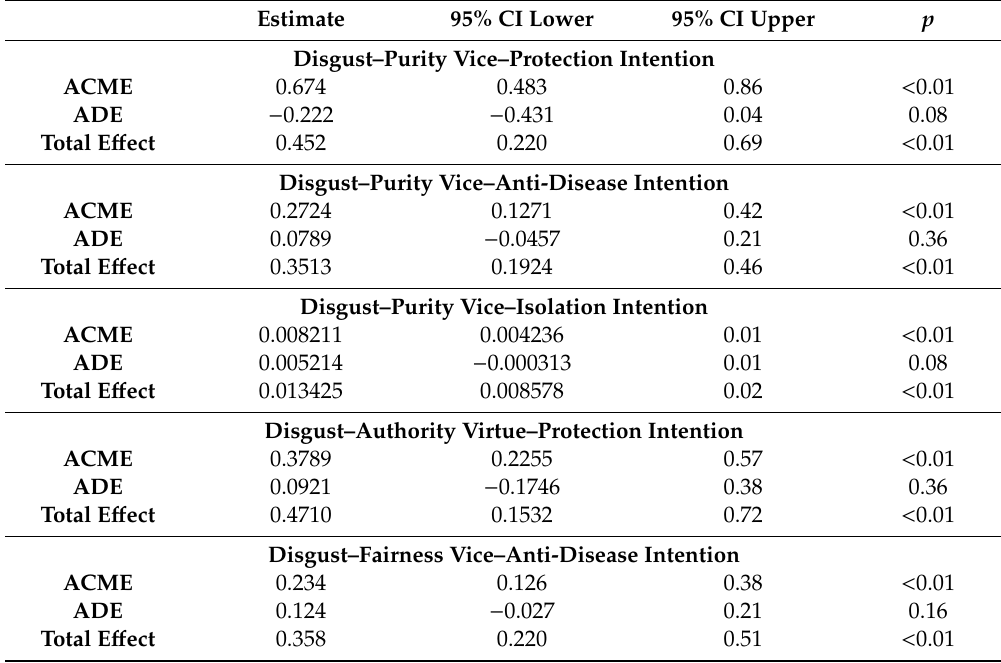
Table 12. Details of mediation